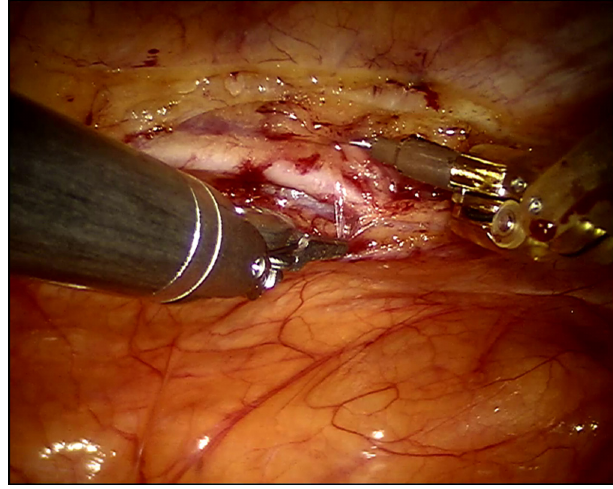
Fig. 1 – Harvesting of the left internal thoracic artery with fine forceps and spatula